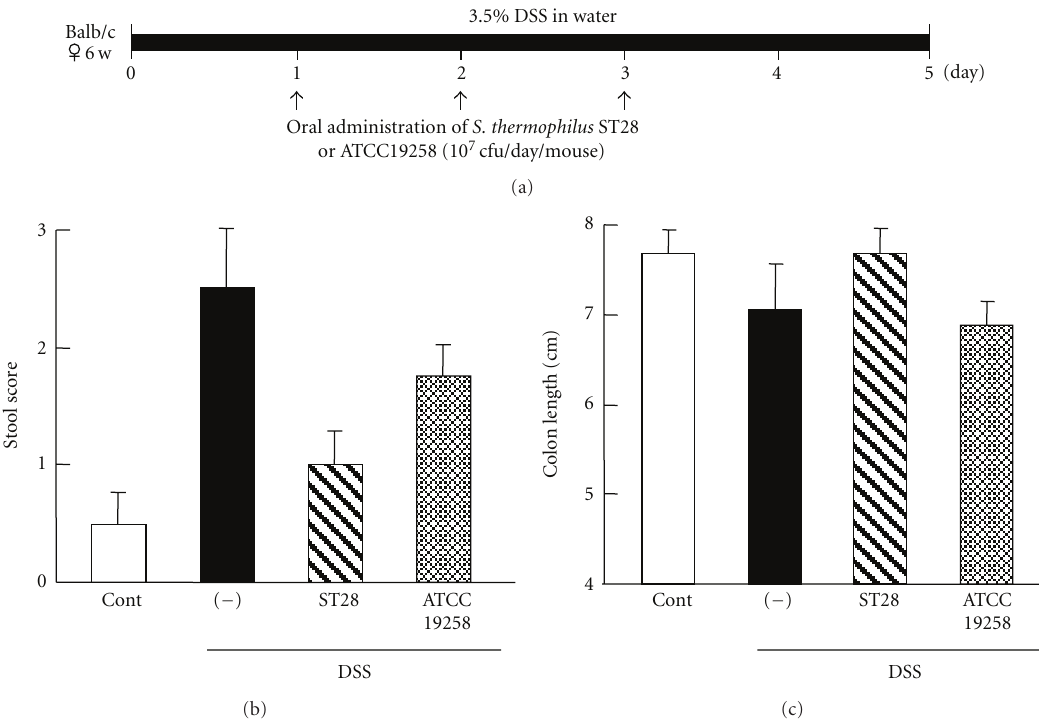
Figure 2: E ff ects of S. thermophilus ST28 administration on colons of dextran-sodium-sulphate- (DSS-) induced colitis mice. (a) Overview of the experimental design. Acute colitis was induced in mice ( n = 4 for each group) by exposure to 3.5% DSS for 5 days. On days 1–3, mice were orally administered ST28 cells or ATCC 19258 (10 7 cfu/day). (b) Inflammation score on Day 5. The severity of inflammation was assessed by assigning a score for consistency and bleeding of stool (full score, 6). (c) Colon length on Day 5. Cont, healthy control mice, ( − ) untreated DSS-induced colitis